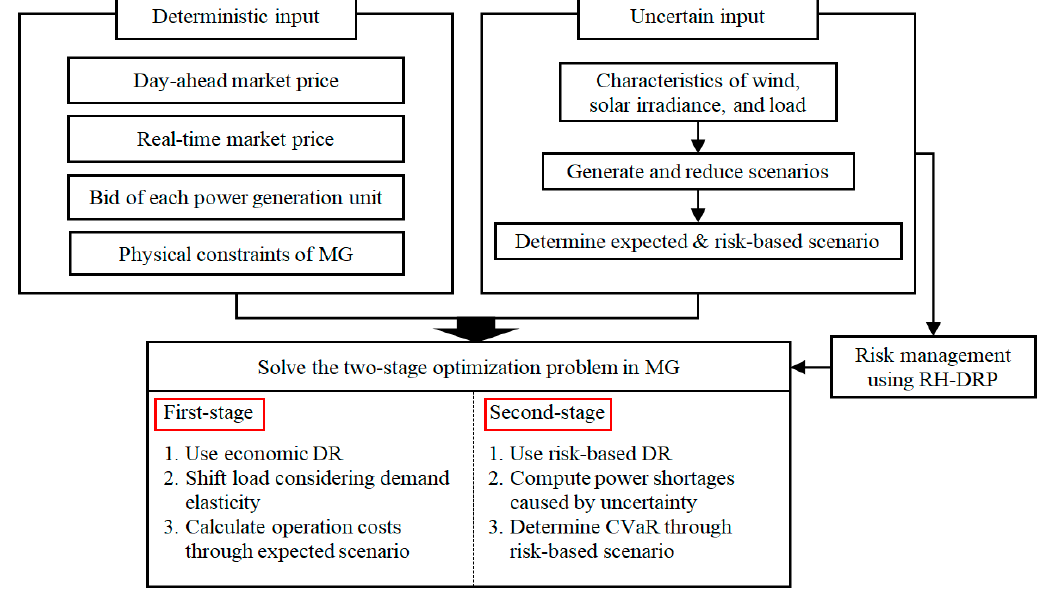
Figure 1. Schematic representation of two-stage optimal operation.